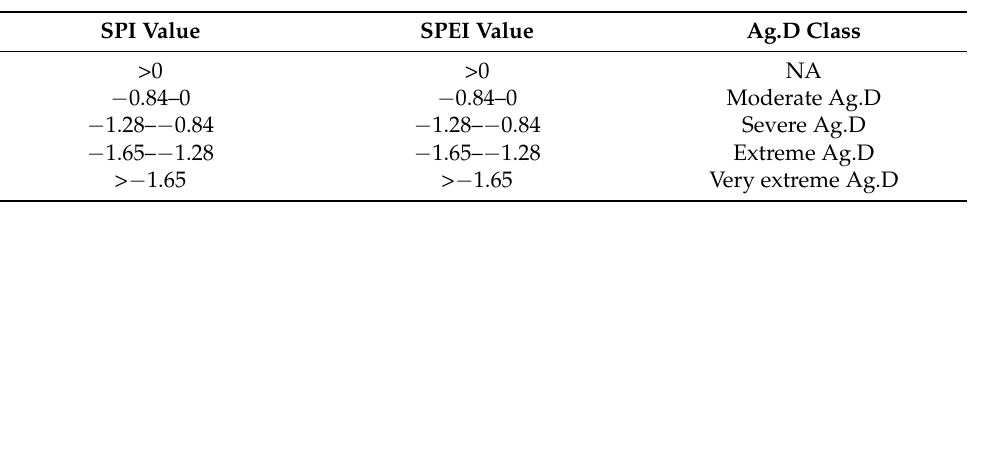
Figure 2. Evolution of sunflower cultivation across Hungary at a national scale (1990–2019): ( a ) harvested sunflower land